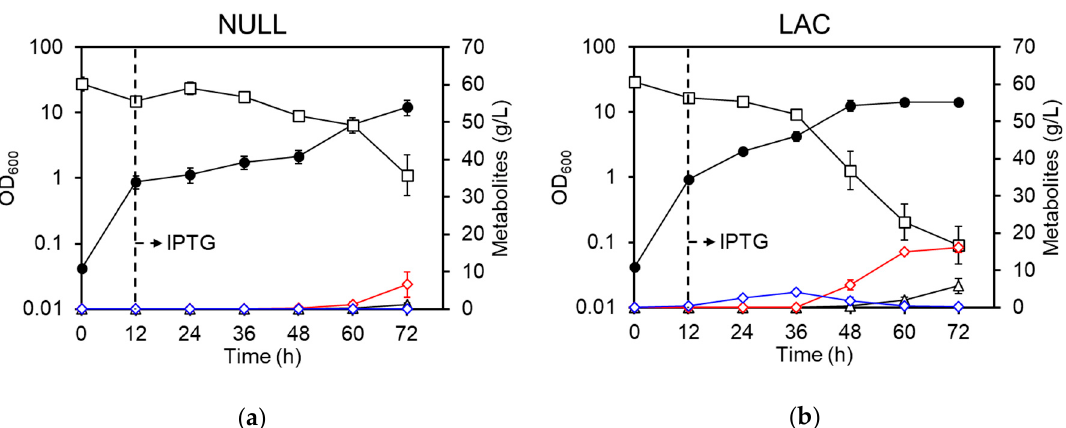
Figure 3. Growth characteristics of the NULL and LAC strains grown under the basal conditions. The ( a ) NULL and ( b ) LAC strains were cultured in N5G medium under the basal conditions [14]. Parameters: temperature, 35 °C; aeration, 1800 rpm (agitation) and 150 mL·min − 1 (airflow rate); pH, 5.7; induction point, 12 h (vertical dashed line). Symbols: filled circles, OD 600 ; squares, glucose; triangles, acetate; red diamonds, pyruvate; blue diamonds, D -lactate. Data shown are the mean ± SD ( n = 3).